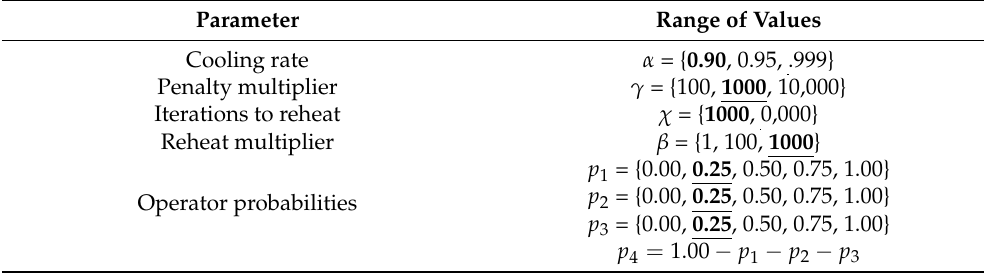
Table 3. Parameter values domains defined for the parameter tuning process of the simulated anneal- ing approach. Default parameter values are underlined and selected values are shown in